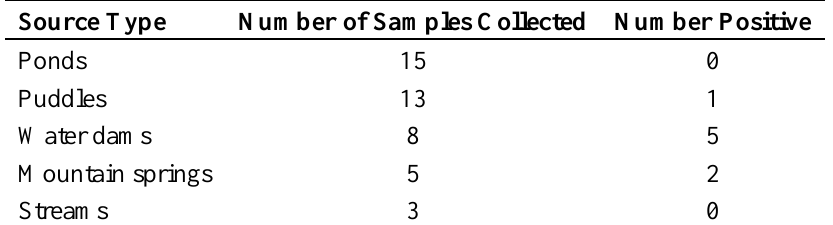
Table 1. Quantitative PCR results for pathogenic Leptospira spp. in environmental water